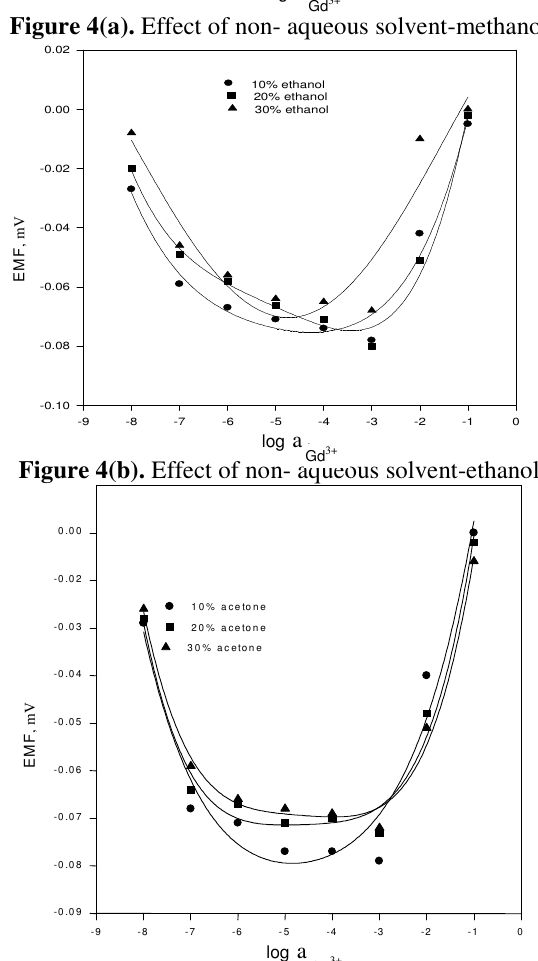
Figure 4(c). Effect of non- aqueous